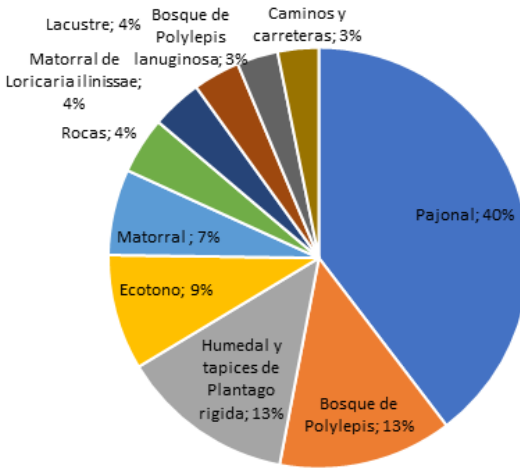
Figure 6. Number of species by preferred